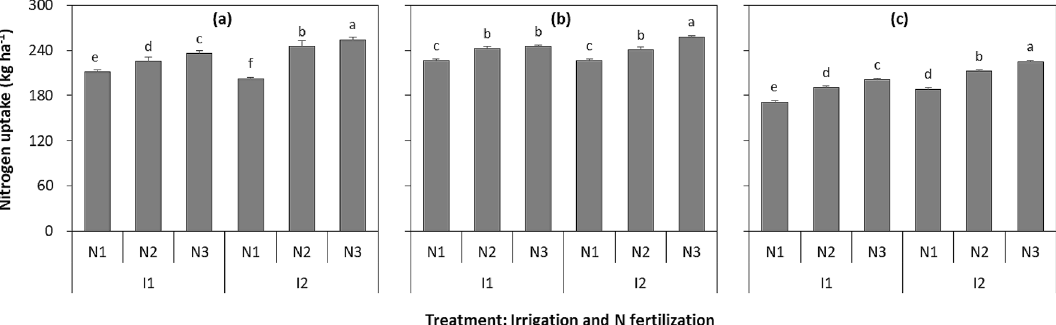
Figure 4. Nitrogen uptake of spring wheat during growing season with two irrigation quotas and three N fertilizer rates in ( a ) 2016, ( b ) 2017, and ( c ) 2018. I1 and I2 represent irrigation amount at 192 and 240 mm, respectively. N1, N2 and N3 represent an N fertilizer rate of 135, 180, and 225 kg N ha −1 , respectively. Different letters indicate significant differences ( P < 0.05) among treatments within a year and the smaller bars are standard error of means (n = 3).